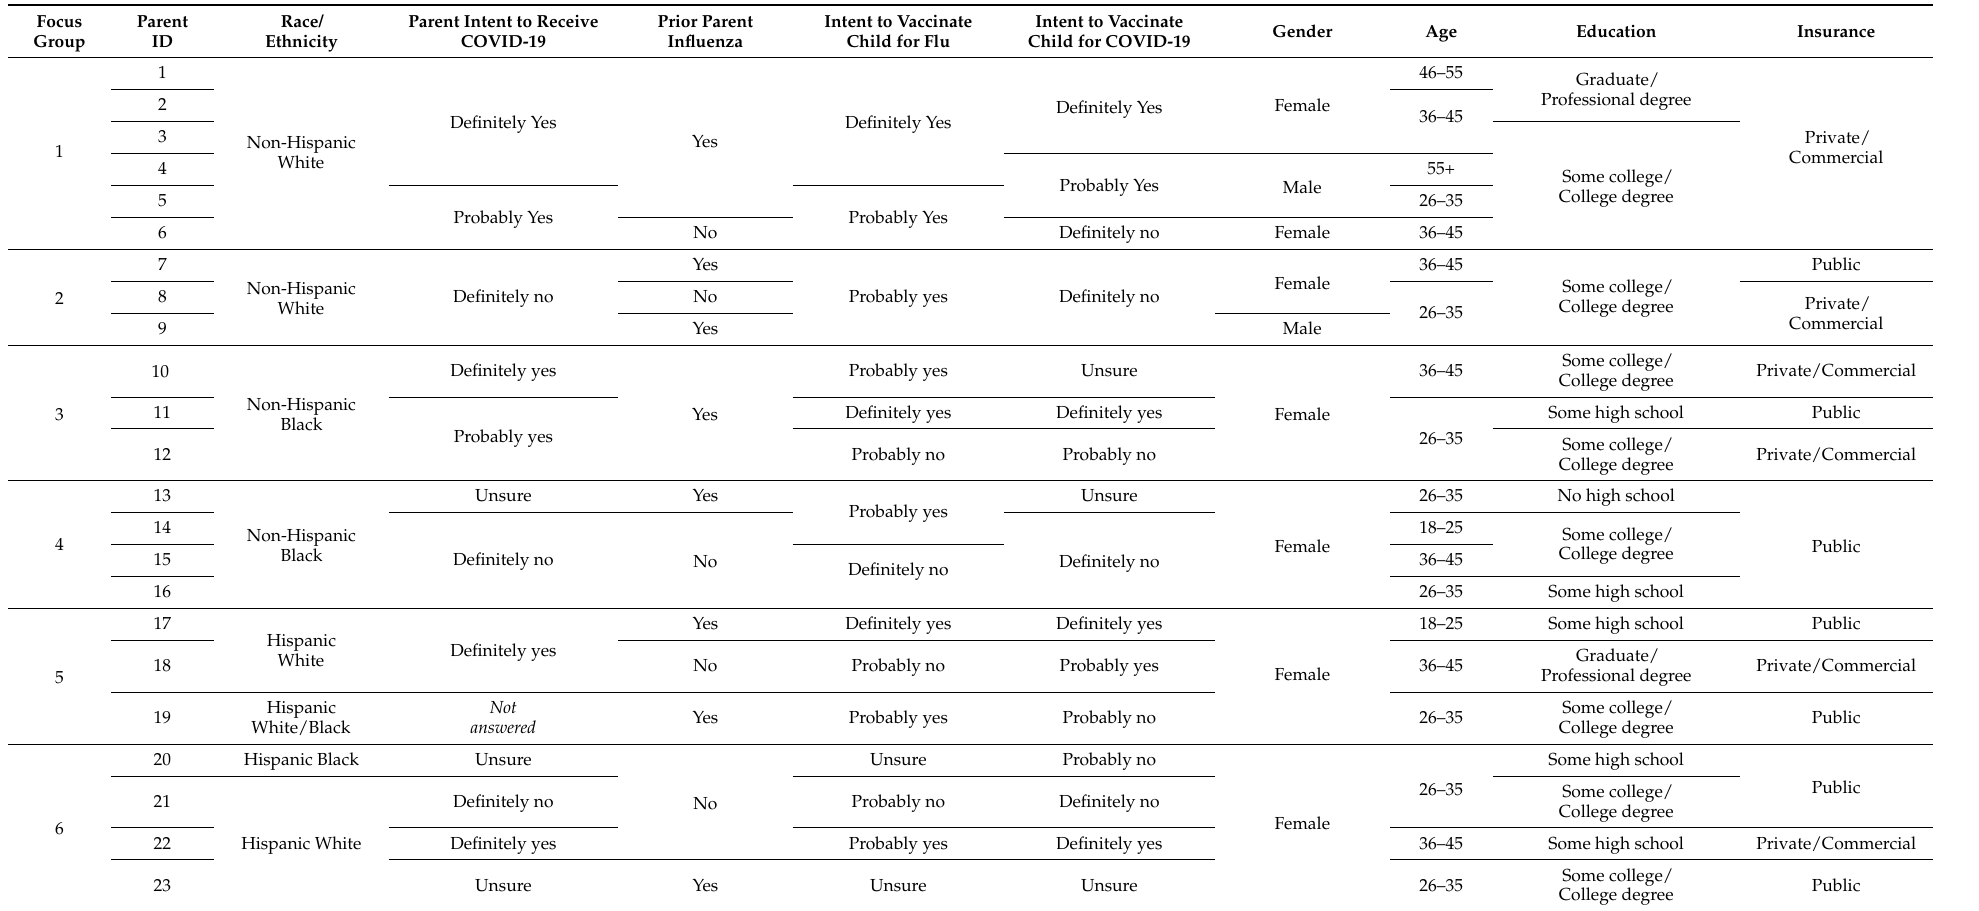
Table A3. Focus Group Participant